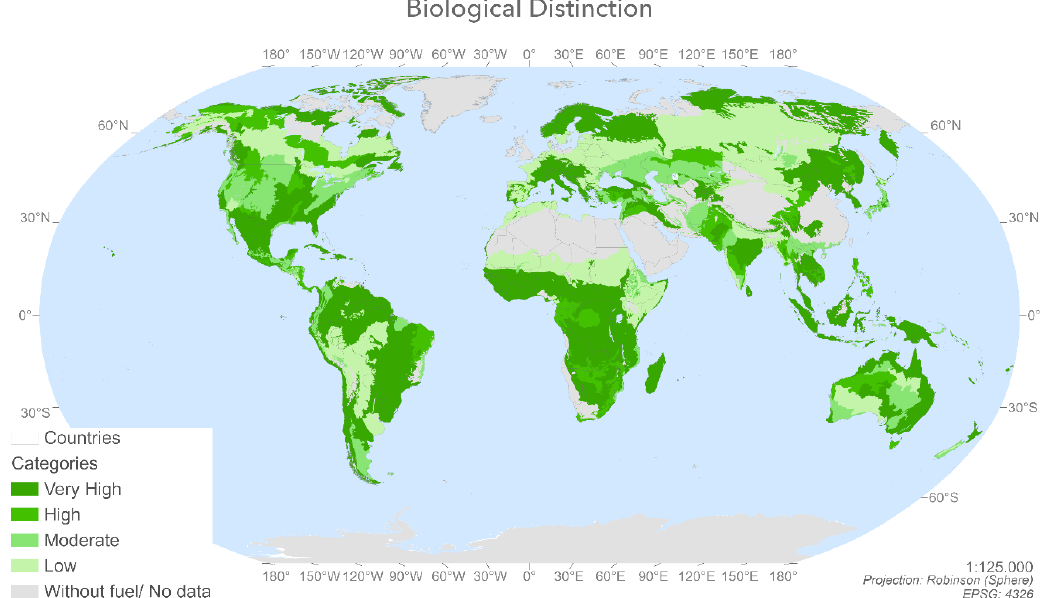
Figure A2. Spatial distribution by ecoregion of the ecosystem biological distinction value prepared by combining the indices for endemic species, species richness, functional diversity and unique habitats by ecoregion evaluated within the biome to which they belong (source: the authors).